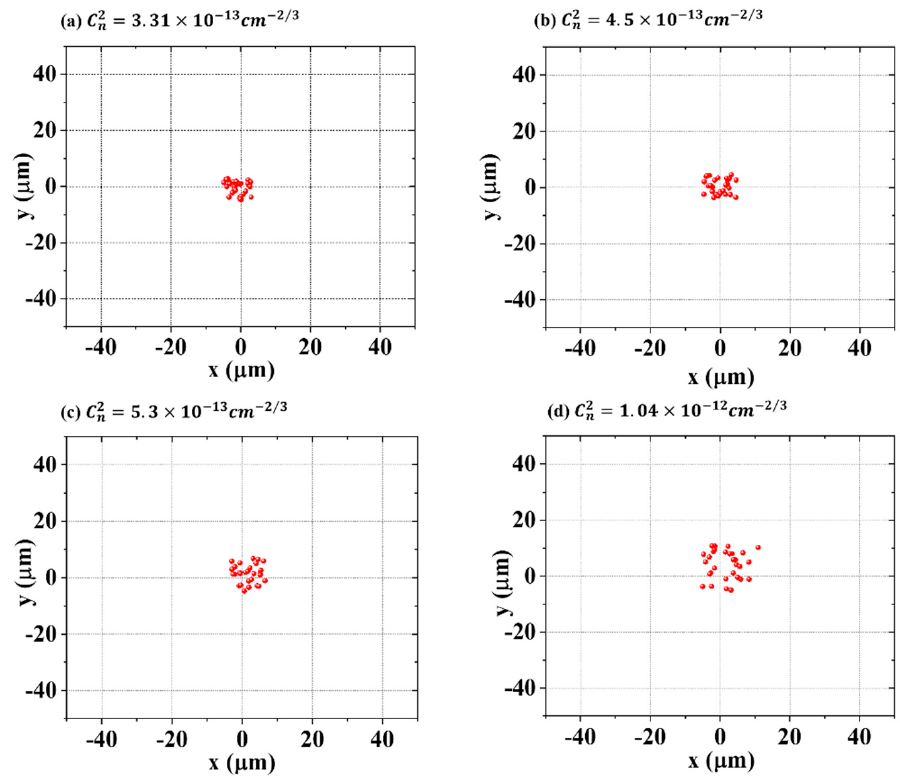
Figure 2. Spatial displacement of beam in turbulent air with various structural constants.